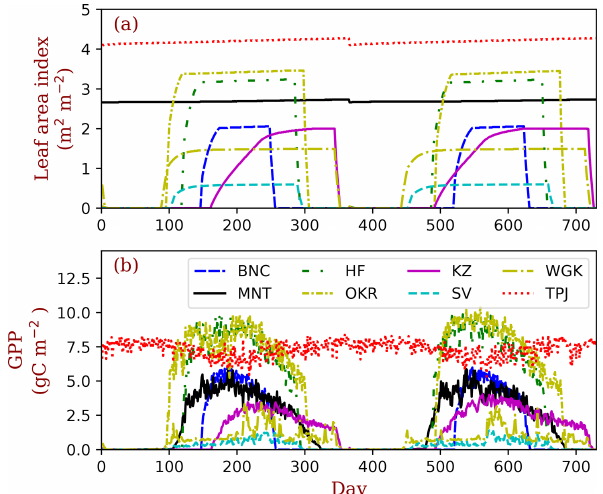
Figure 5. Seasonal patterns of LAI and gross primary production (GPP) in the sample grids. In total, 2 years of data are shown in this figure. The key to the location abbreviations is given in Table